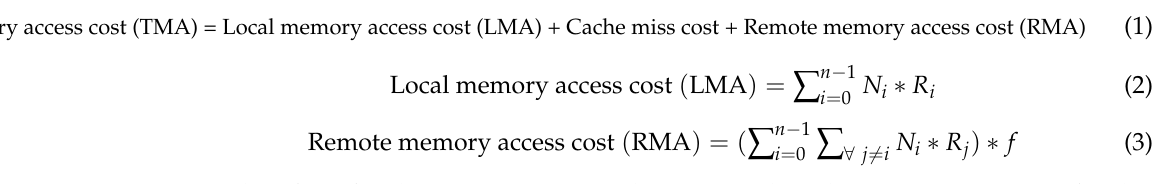
Figure 4. Migrating one thread of a specific thread group across